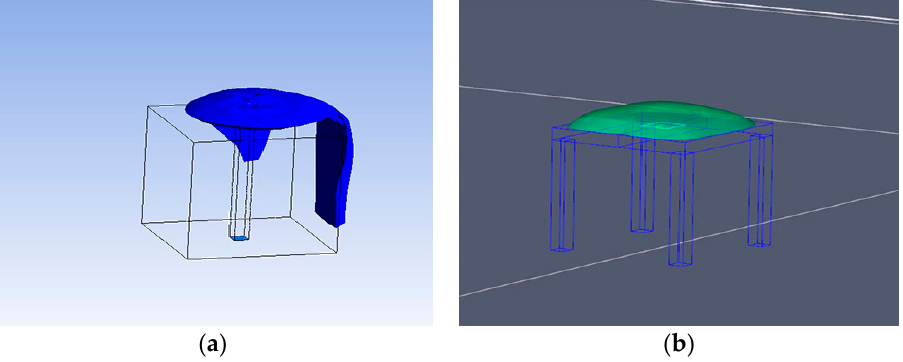
Figure 5. Iso-surface for propane representing 25% concentration of LEL for ( a ) Ansys software and ( b ) FDS.